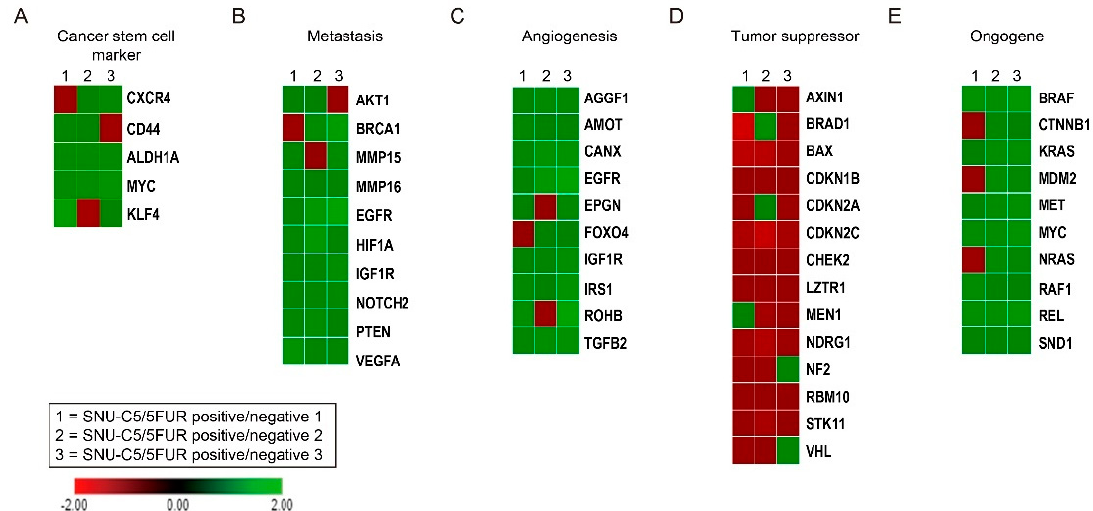
Figure 2. Gene analysis of CRC cells by the PrP C expression. RNA-seq analysis of PrP-positive and PrP-negative SNU- C5/5FUR (n = 3). RNA-seq analysis of fold changes in PrP-positive vs. PrP-negative cells was categorized as a cancer stem cell marker ( A ), metastasis ( B ), angiogenesis ( C ), tumor suppressor ( D ), and oncogene ( E ).